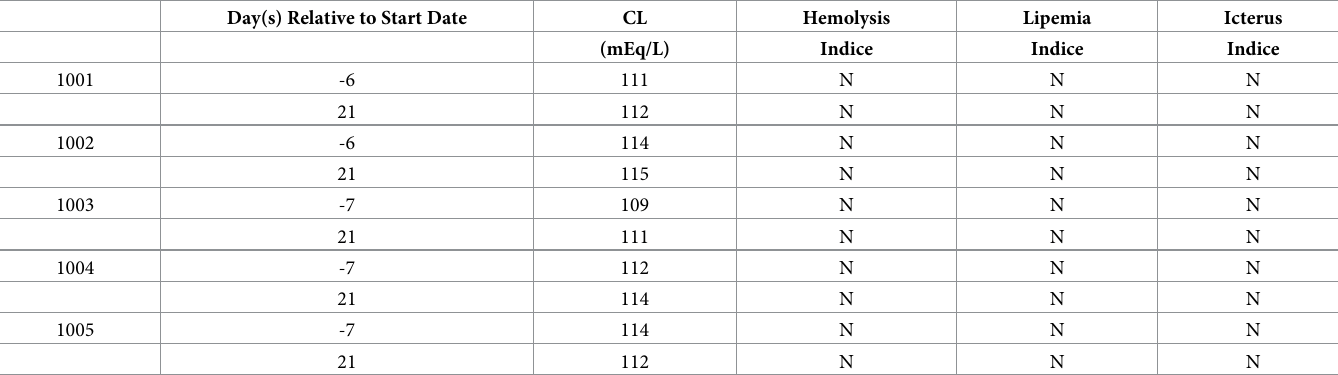
Table 7. Biochemistry reporting for each animal for CL, Hemolysis Indice, Lipemia Indice, and Icterus Indice. Day(s) Relative to Start Date